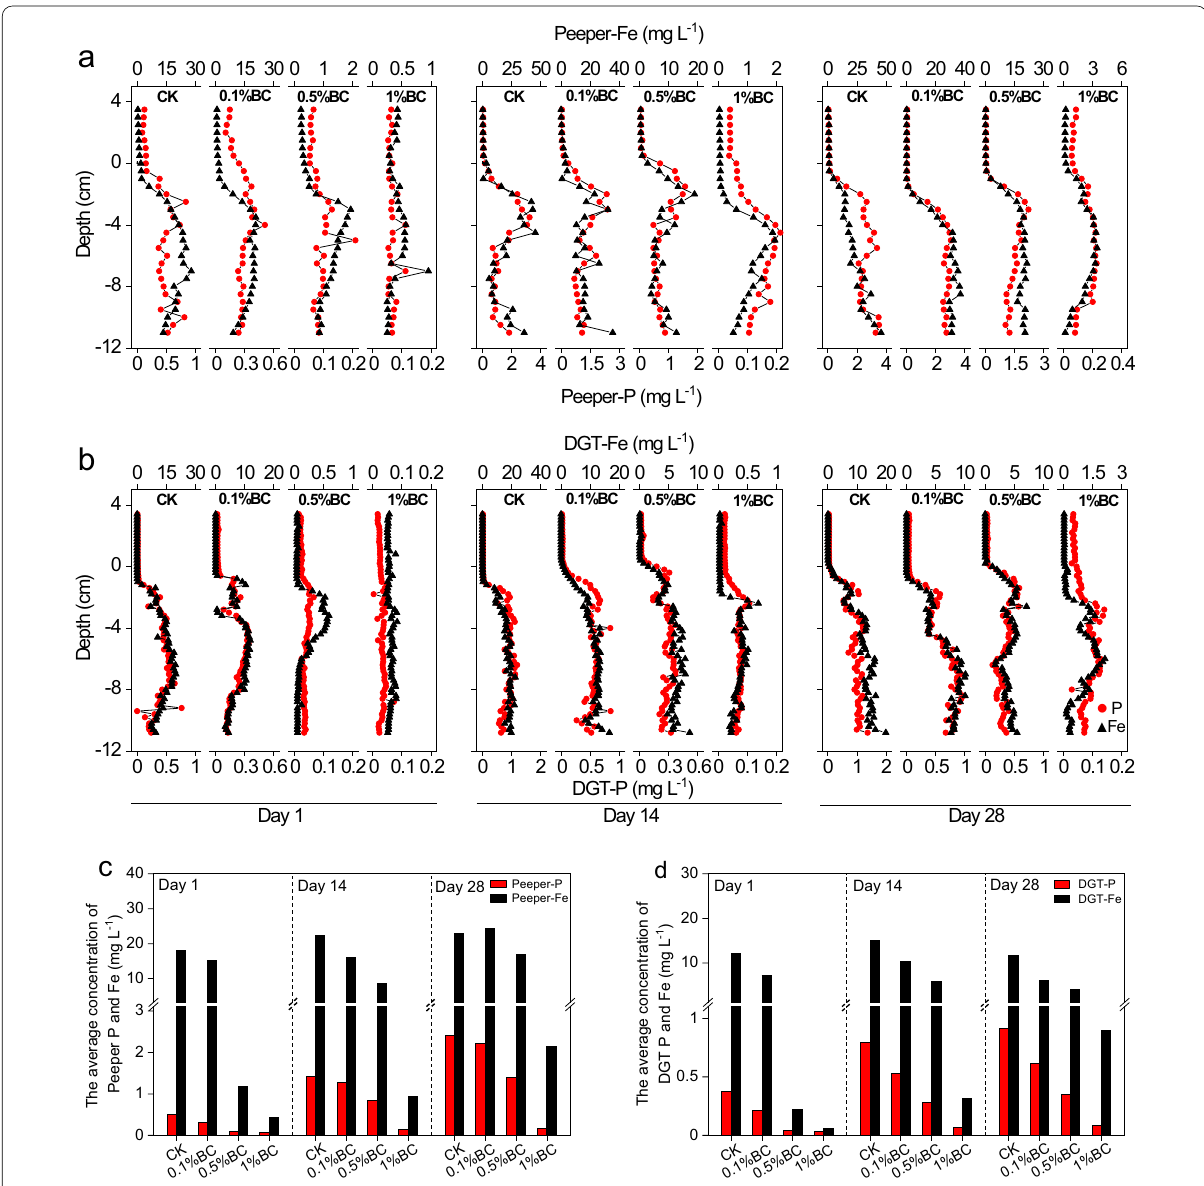
Fig. 2 Variation of Peeper-P/Fe (soluble P/Fe) ( a ) and DGT-P/Fe (labile P/Fe) concentrations ( b ) measured by HR-Peeper and 1D-DGT in the paddy soil around rice roots at rice seedling stage under four biochar treatments in-situ under greenhouse pot experiments on days 1, 14, and 28 . The average concentration of Peeper-P/Fe ( c ) and DGT-P/Fe ( d ) for the entire profile was calculated. CK, 0.1%BC, 0.5%BC, and 1%BC are referred as biochar addition rates at 0, 2.25, 11.25, and 22.5 t ha − 1 ,